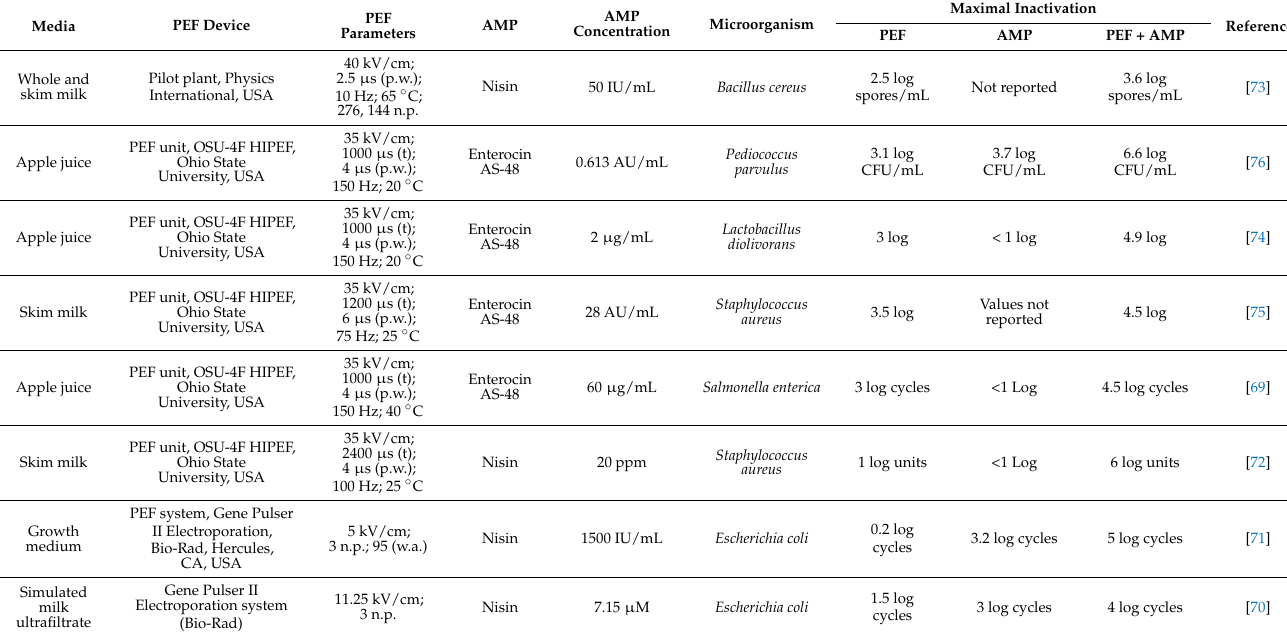
Table 5. Effect of pulsed electric fields (PEF) and antimicrobial peptides (AMPs) on microbial inactivation in food